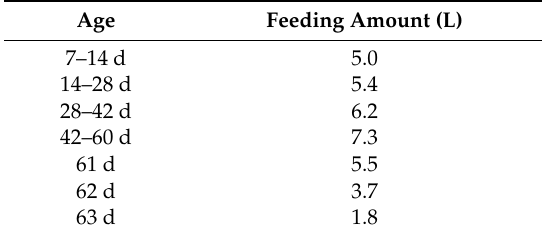
Table 1. The amount of liquid feed during 7 to 63 days old.